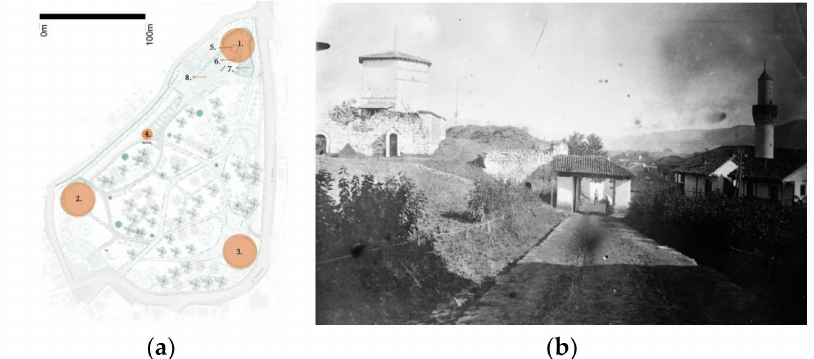
Figure 2. Details of city fortress. ( a ) Scheme of the facilities of the City Fortress—Actual